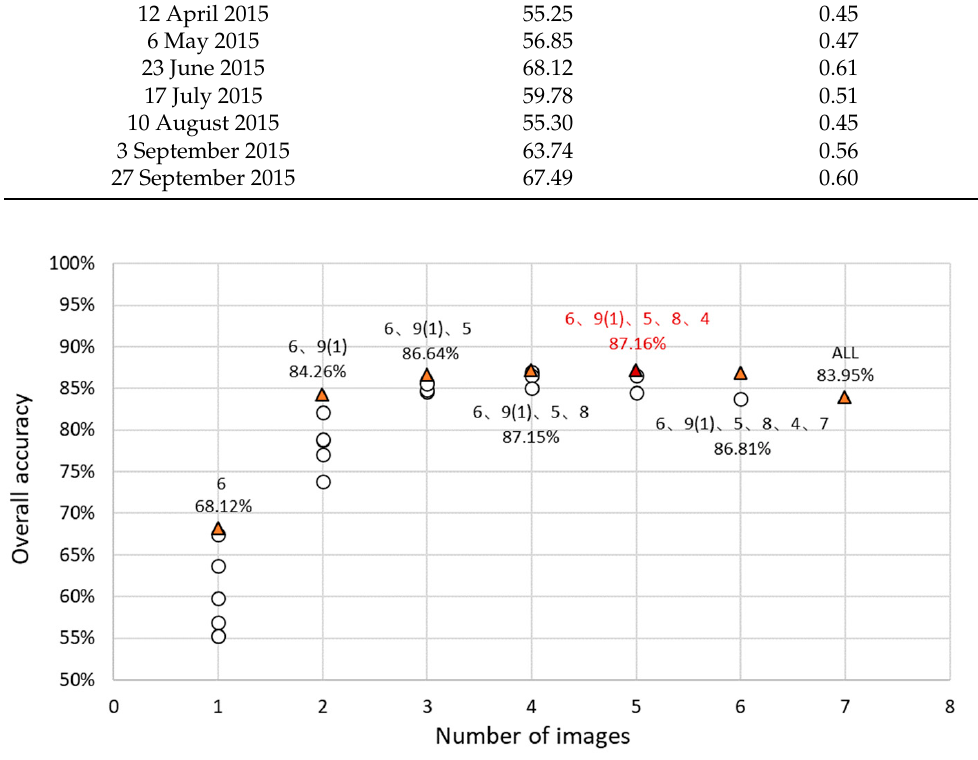
Figure 15. The RF overall accuracies for the optimal combination SAR image produced by a forward image selection procedure using all polarimetric observables after exchanging the training and testing samples in previous tests. Note that numbers in the figure denote the best accuracy in each step (at the bottom), and combinations of SAR images (at the top), for example “6, 9(1), 5, 8, 4” represents the combination of images dated 23 June, 3 September, 6 May, 10 August, and 12 April (see Table